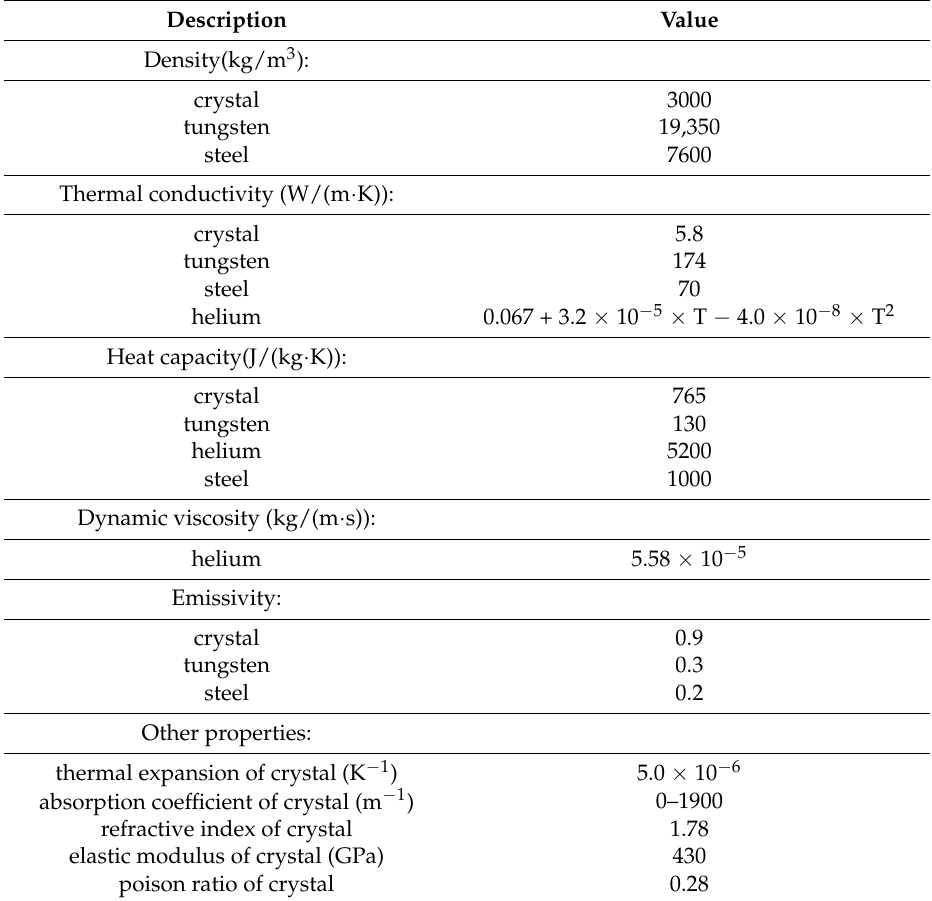
Table 1. Thermophysical properties of